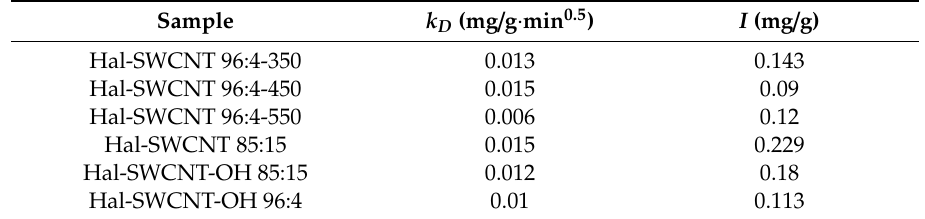
Table 7. Interparticle and film di ff usion rate parameters for ANT adsorption on Hal-CNT composites.